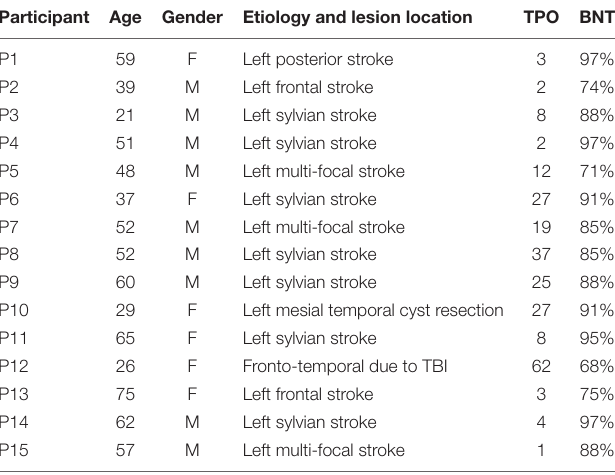
TABLE 1 | Demographic, lesion and behavioral data of the 15 aphasic individuals. Participant Age Gender Etiology and lesion